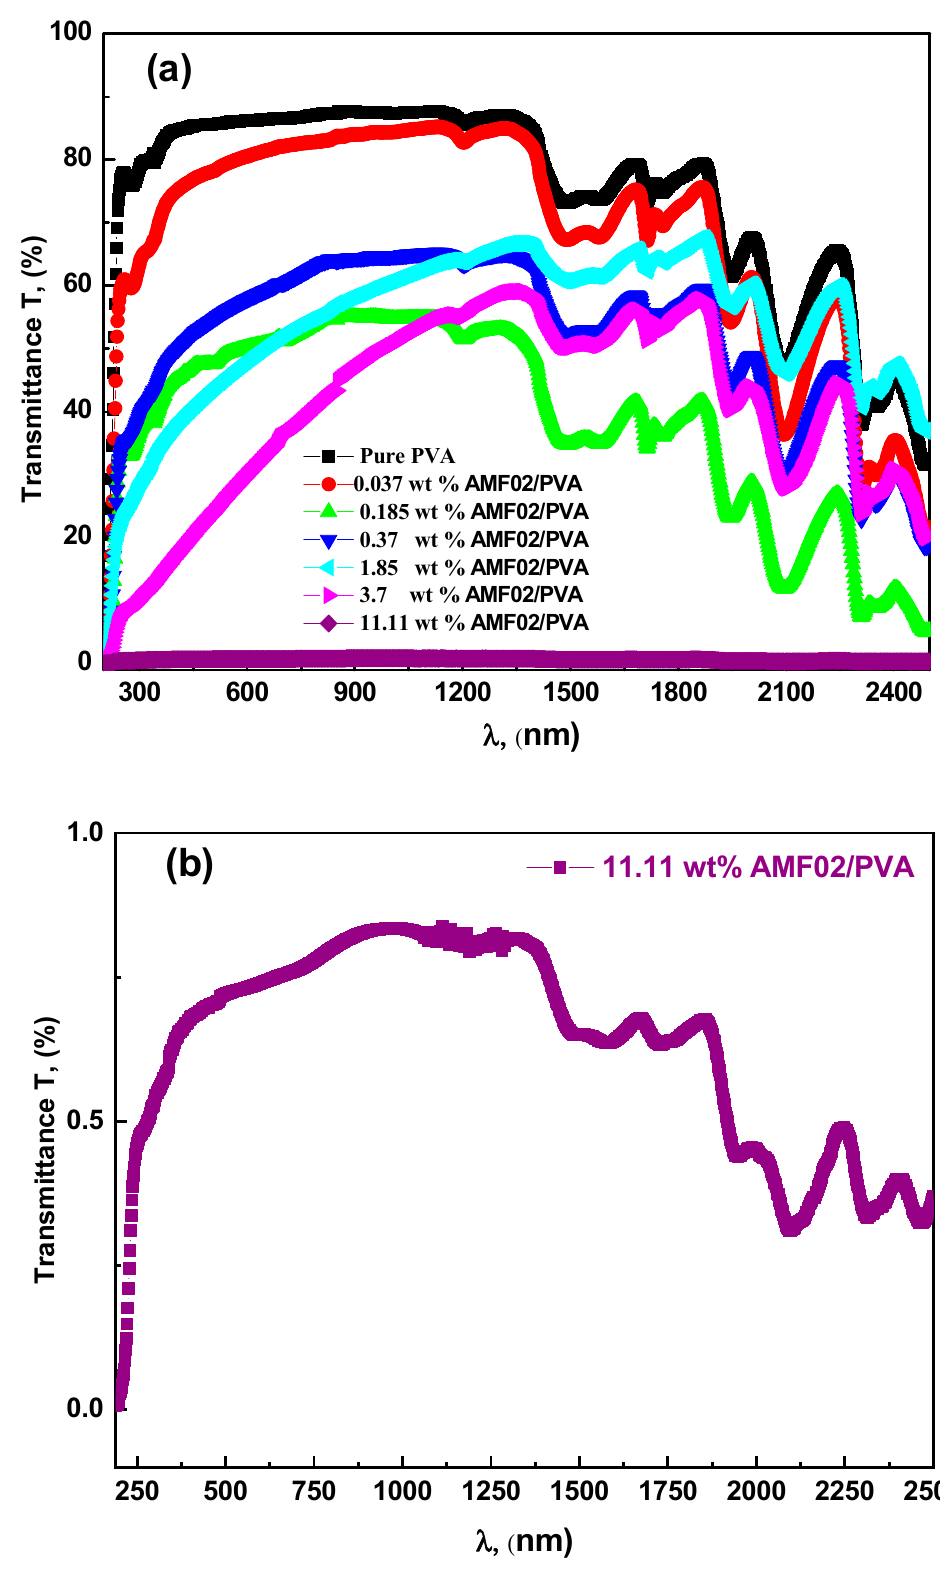
Figure 3. Transmittance plots ( a ) for different AMF02/PVA novel PCCEFs, and ( b ) for 11.11wt% of AMF02 salt content.